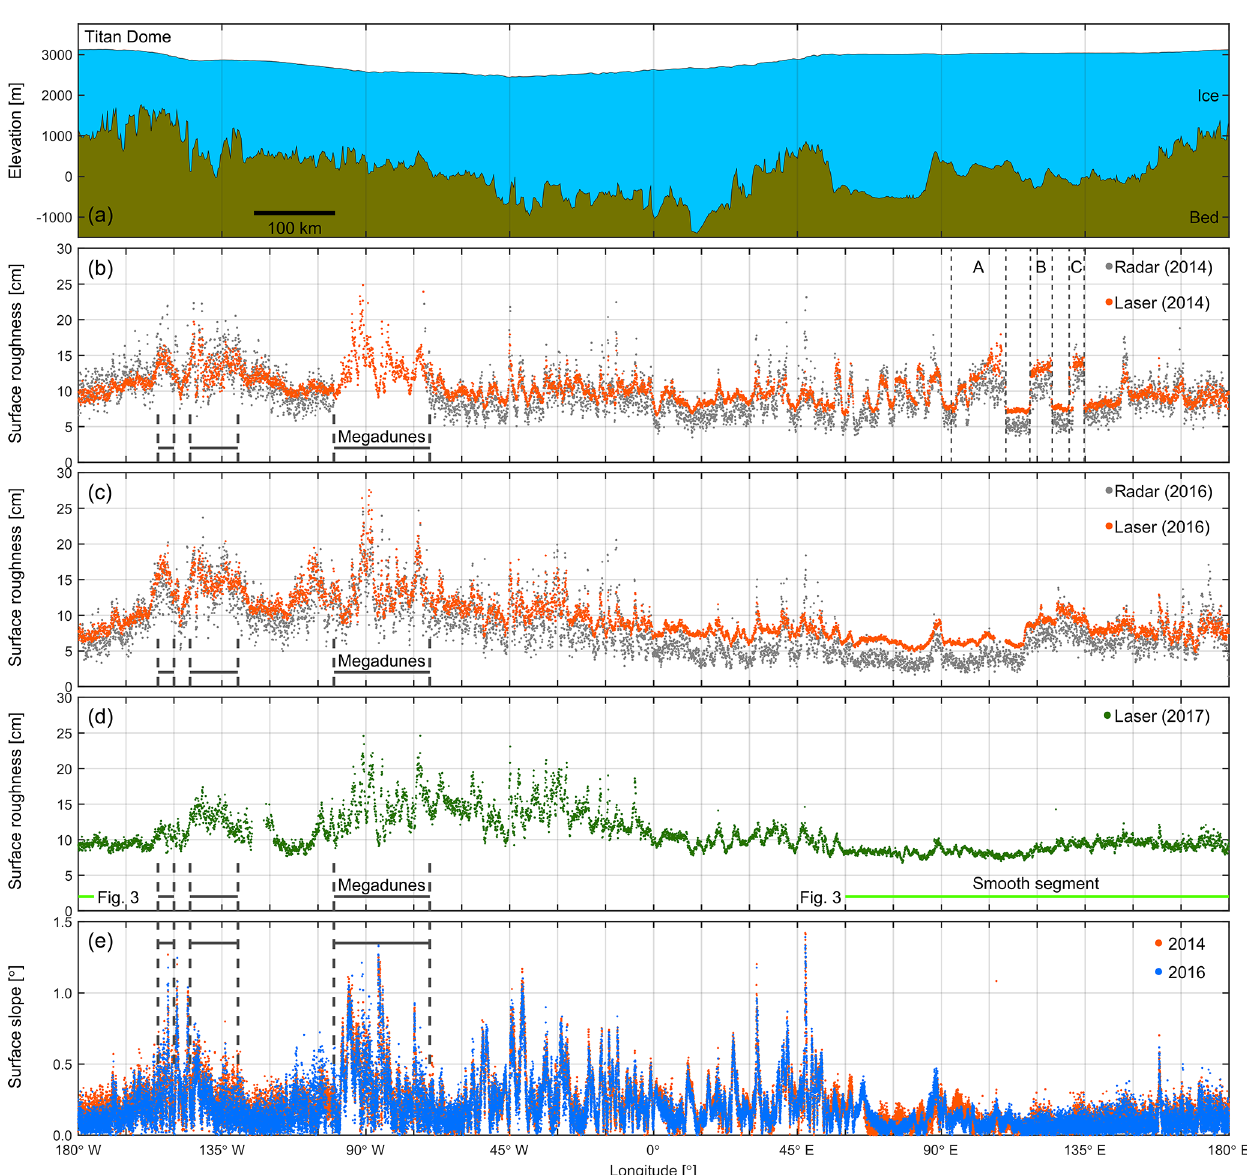
Figure 4. (a) Ice surface elevation from 2014 ATM data (Studinger, 2014, updated 2018) and bedrock topography from 2014 CReSIS Multichannel Coherent Radar Depth Sounder (MCoRDS) data (Leuschen et al., 2010, updated 2018). The profile starts at Titan Dome (TD) and moves clockwise around 88 ◦ S. (b) Surface roughness from 2014 ATM laser and snow radar data. A 14min disk failure of the snow radar in 2014 resulted in a data gap over the megadunes. (c) Same for 2016. (d) Surface roughness from 2017 UAF laser data. The location of the smooth segment between 175 ◦ W and 60 ◦ E that is discussed in Sect. 3.4 and also shown in Fig. 3b is indicated by a green line. (e) Surface slope from 2014 and 2016 ATM ICESSN data using only the nadir platelet (Studinger, 2014, updated 2018). Heavy dashed lines in (b) – (e) mark megadune areas, and thin dashed lines in (b) indicate distinct abrupt changes in surface roughness in